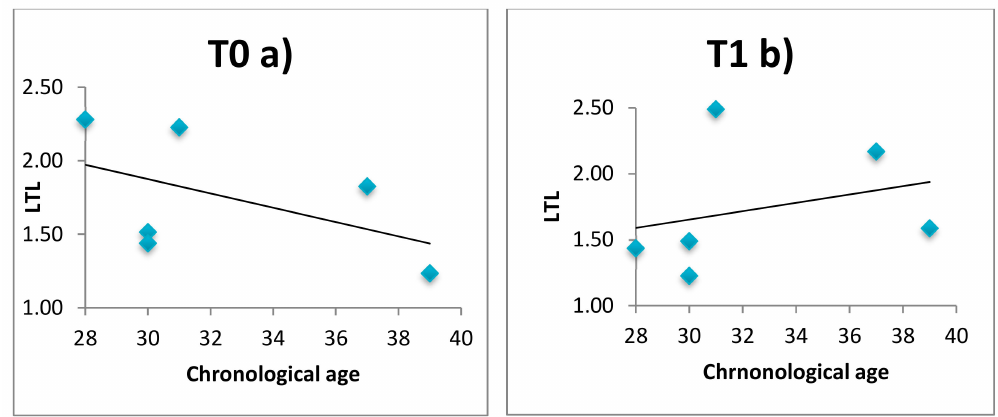
Figure 4. Comparison of the correlation curves between LTL and chronological age at enrolment T0 ( a ) versus after 60 days T1 ( b ) based on Chow’s test for healthy subjects. Chow Test F (2, 8 df) = 11,889 ( p <